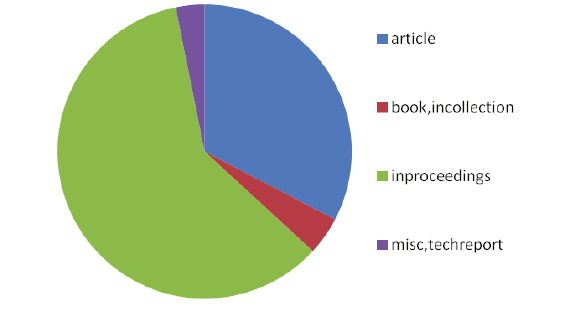
Fig. 1. Distribution of